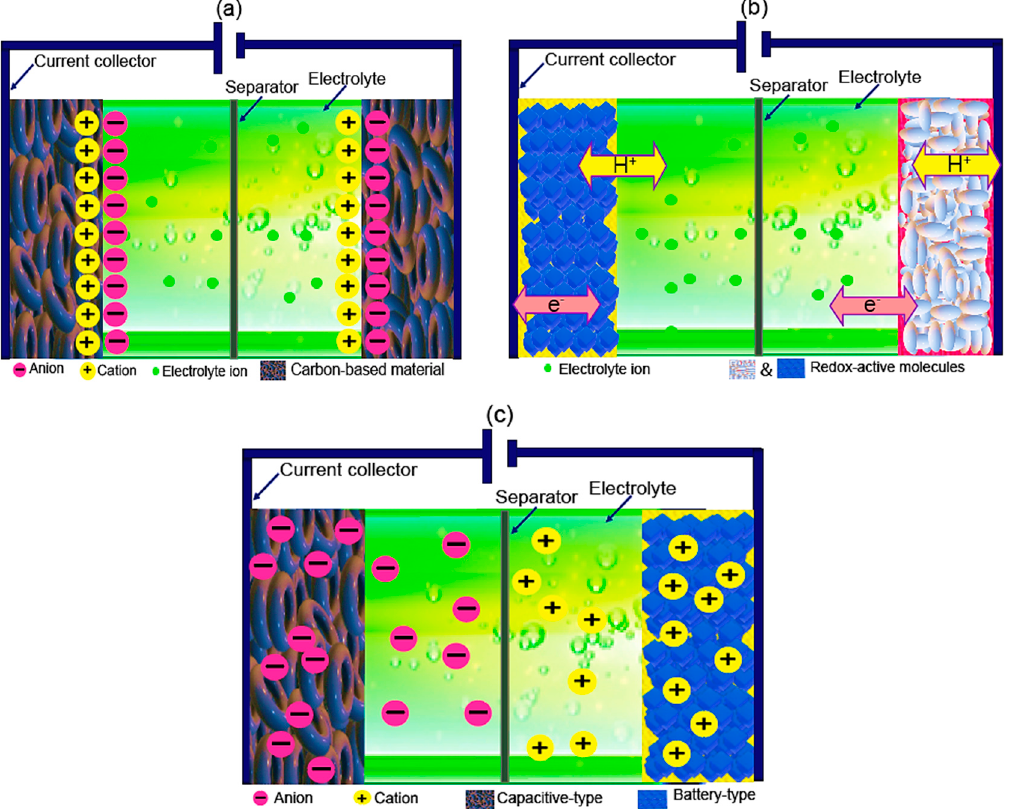
Figure 2. Schematic illustration of supercapacitors: ( a ) electrical double-layer capacitors (EDLC), ( b ) Pseudocapacitors, and ( c ) hybrid supercapacitors (HSCs).